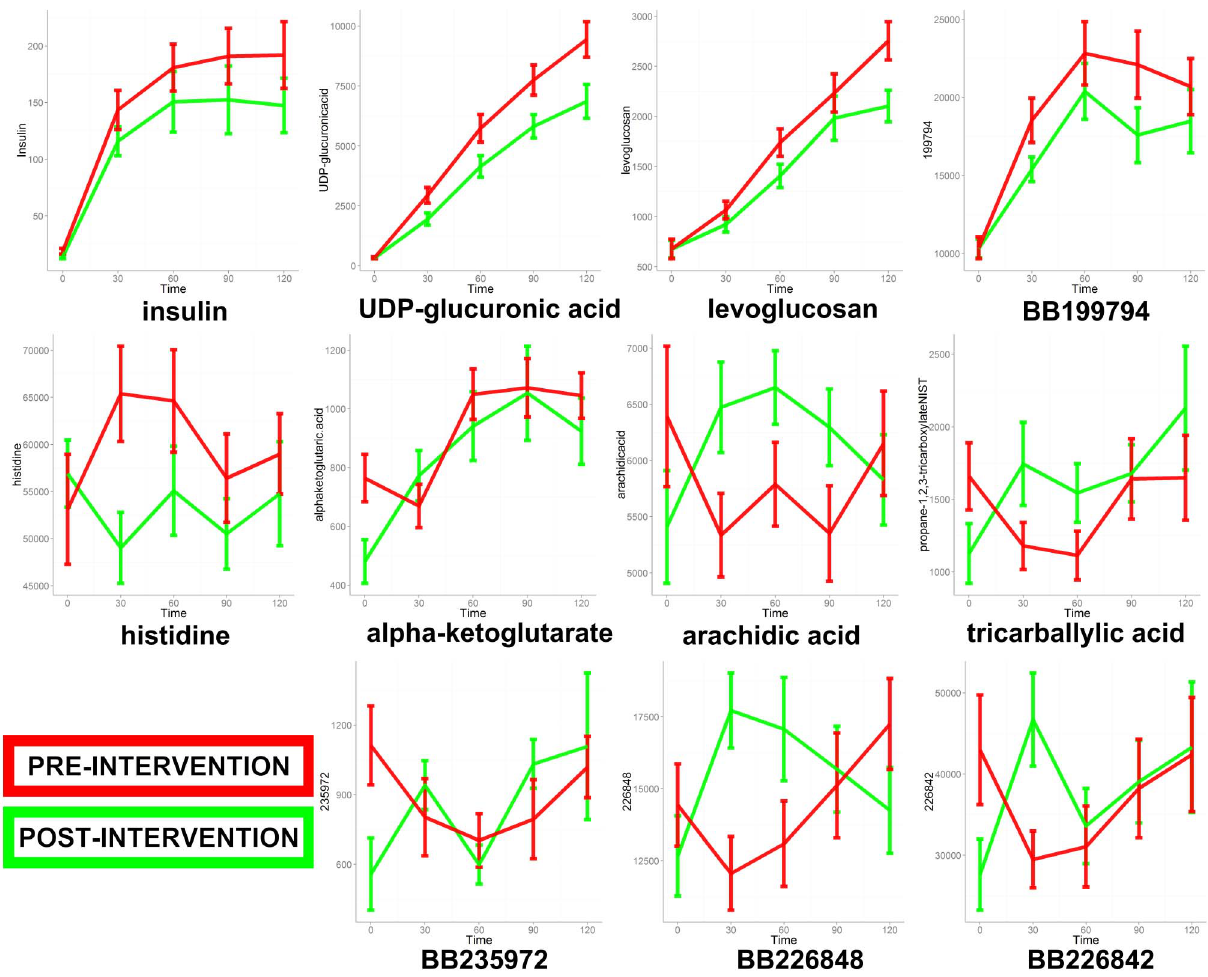
Figure 4. Post-OGTT excursions in plasma concentrations of metabolites that displayed a significant difference in area-under-the- curve (AUC) when comparing the pre- and post-intervention phases (red and green lines, respectively) of a weight loss and fitness regimen in women. Values are quantion peak heights for each of the individual metabolites.